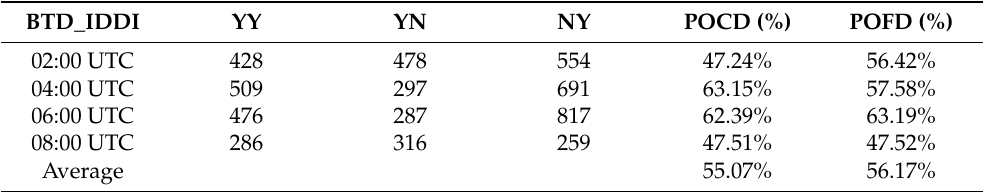
Table 7. Statistical metrics for the comparison between the BTD superimposed IDDI dust identifica- tion and the PM10